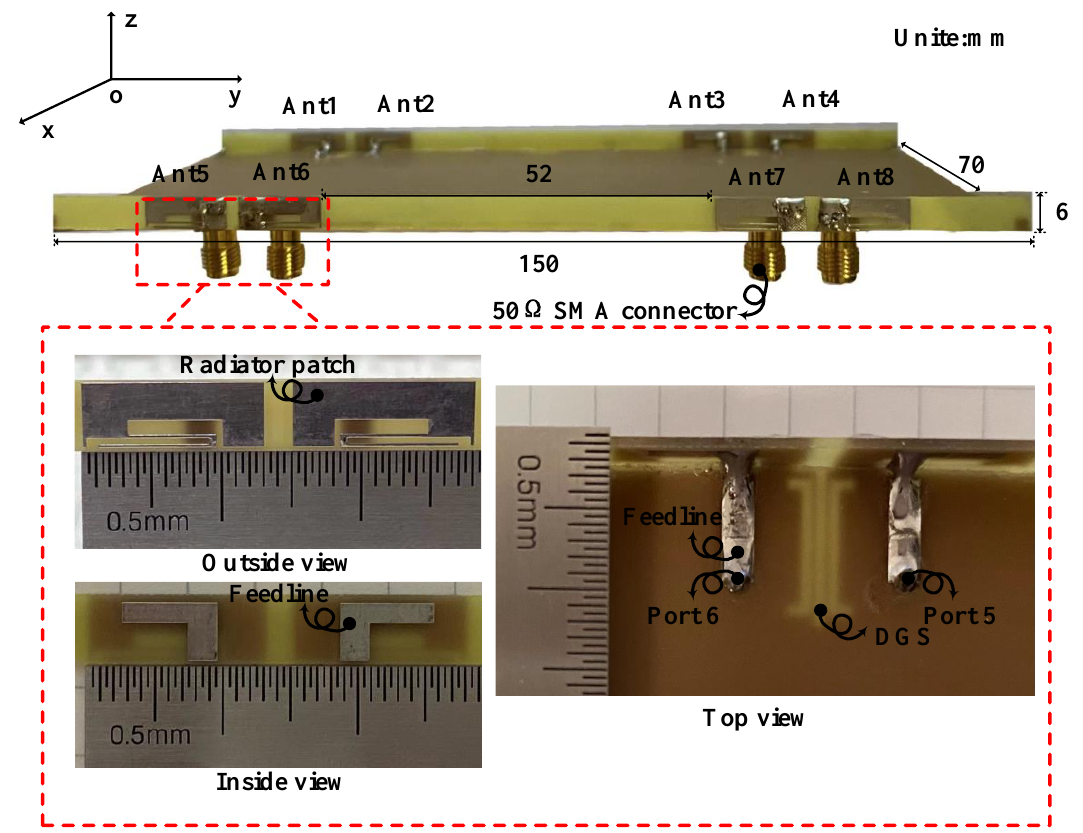
Figure 12. Geometry and photos of the fabricated eight-port MIMO system.